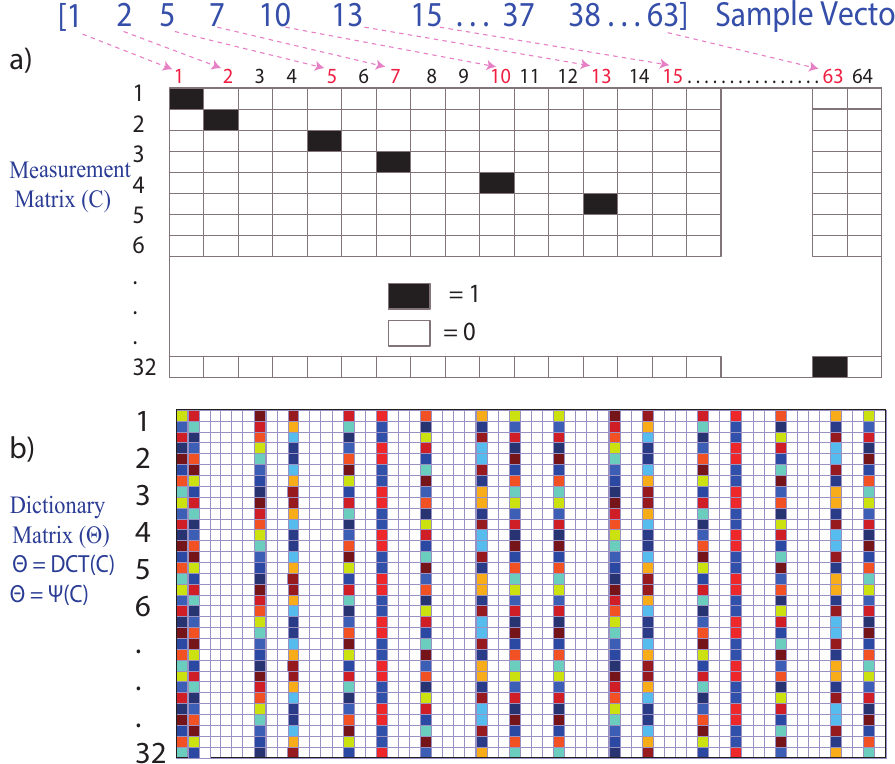
Figure 5. ( a ) Measurement matrix (C). ( b ) Dictionary matrix ( Θ